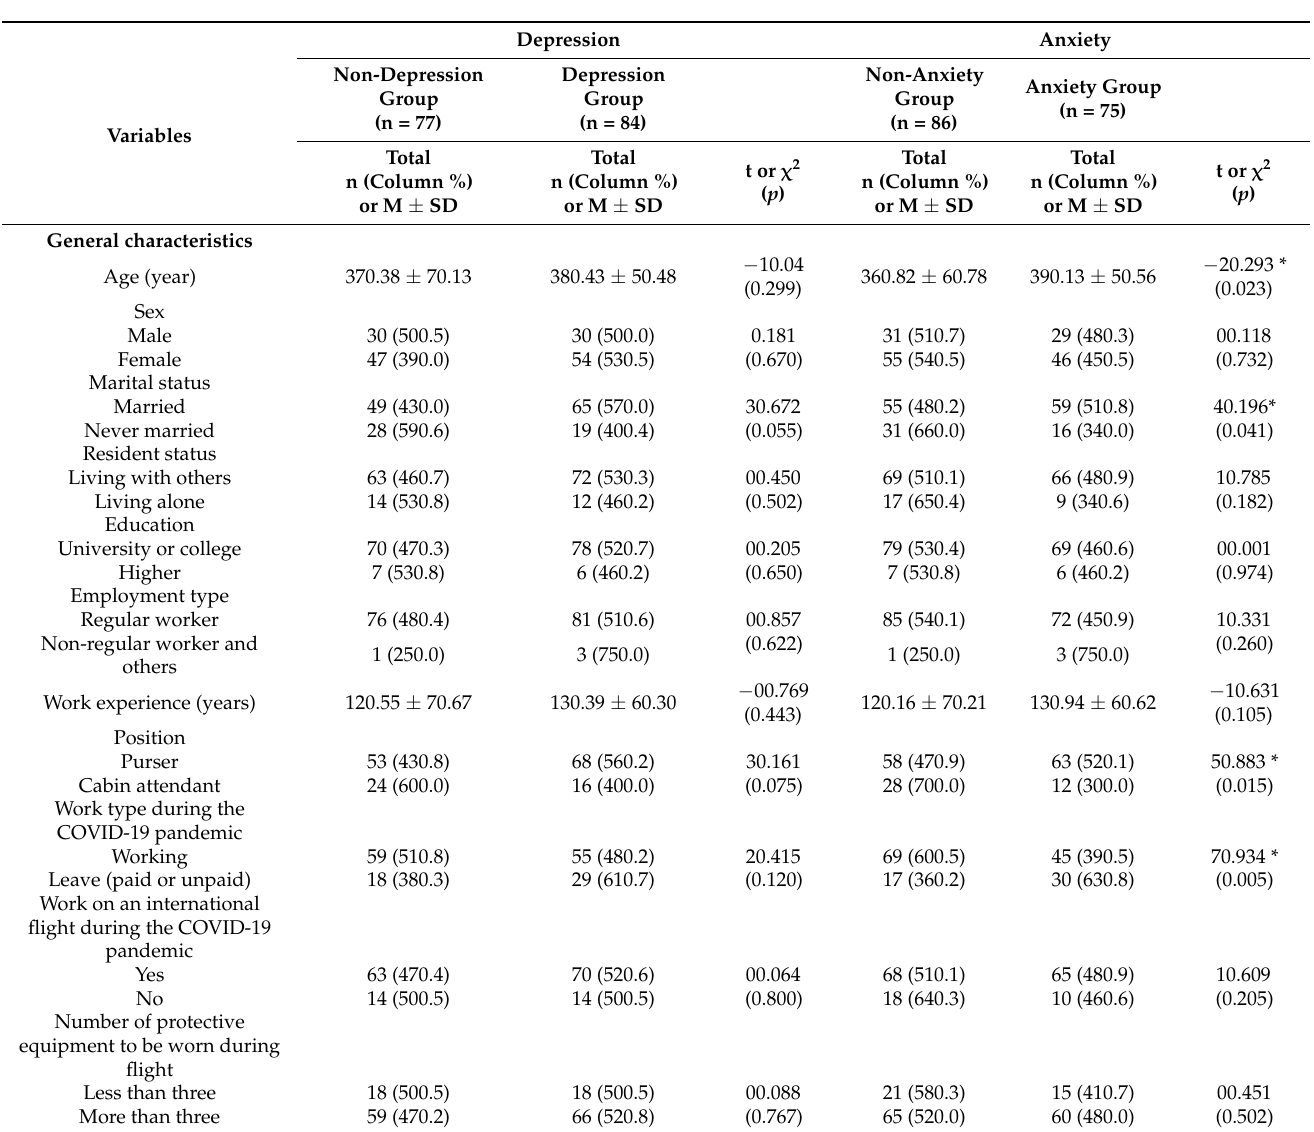
Table 3. Differences in the general characteristics and main variables in the depression and anxiety